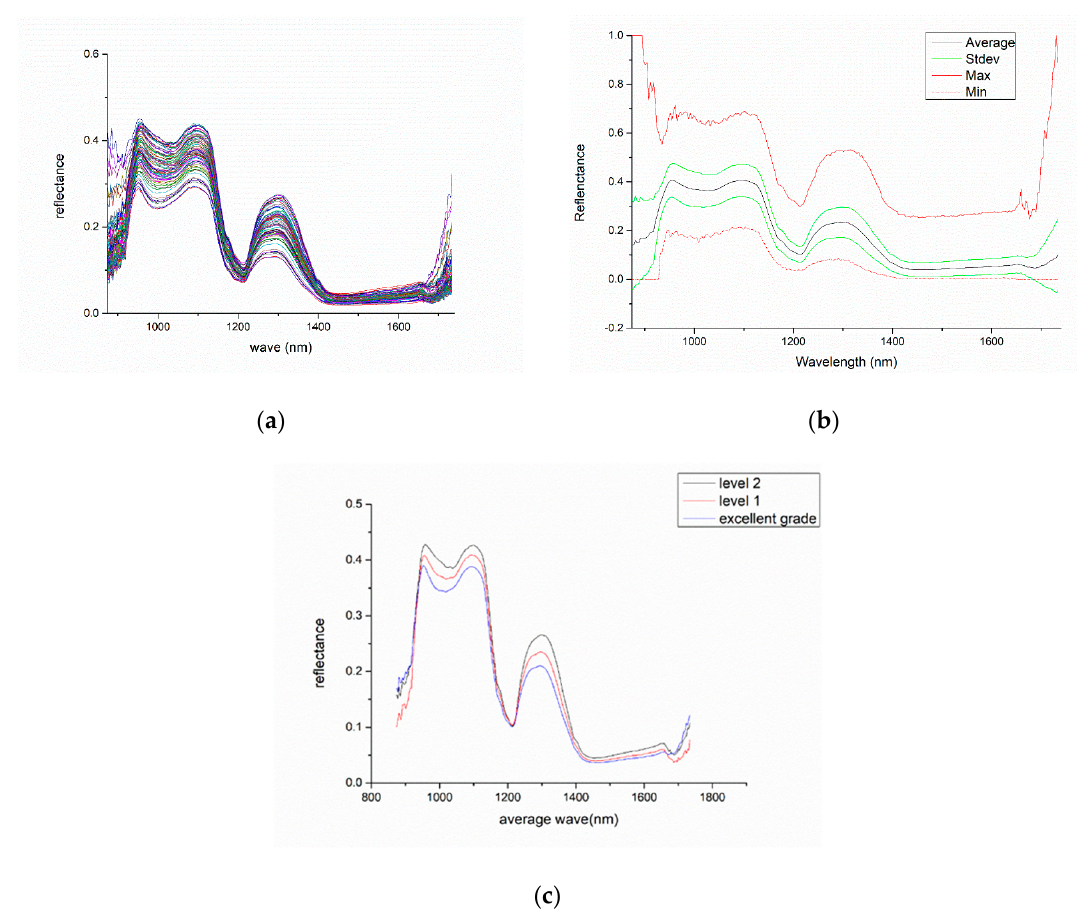
Figure 3. ( a ) Average spectrum of region of interest (ROI) for 80 samples in NIR bands (874–1734 nm); ( b ) NIR reflectance spectra of all 80 sausage samples, the red line and yellow line are the maximum and minimum reflectivity of all samples corresponding to each wavelength, and the green line represents the standard deviation of the corresponding wavelength, which can reflect the effective information contained in each wavelength; ( c ) Average hyperspectral reflectance of sausage samples in three degrees.